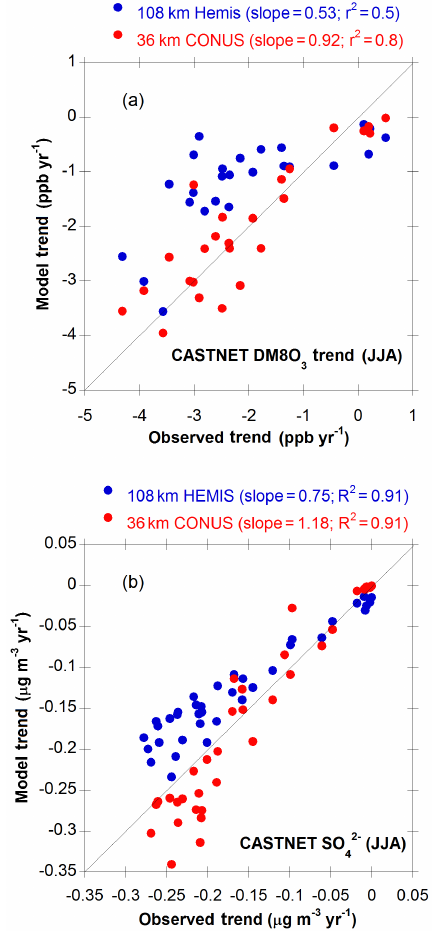
Figure 15. Comparison model and observed summertime (JJA) 1990–2010 trends at CASTNET monitoring sites in the United States for (a) JJA average daily maximum 8h average O 3 and (b) JJA average SO 2 − . Model results from the 108km resolution 4 hemispheric CMAQ simulation are shown in blue, while results from a 36km resolution nested model calculation over the contigu- ous United States are shown in